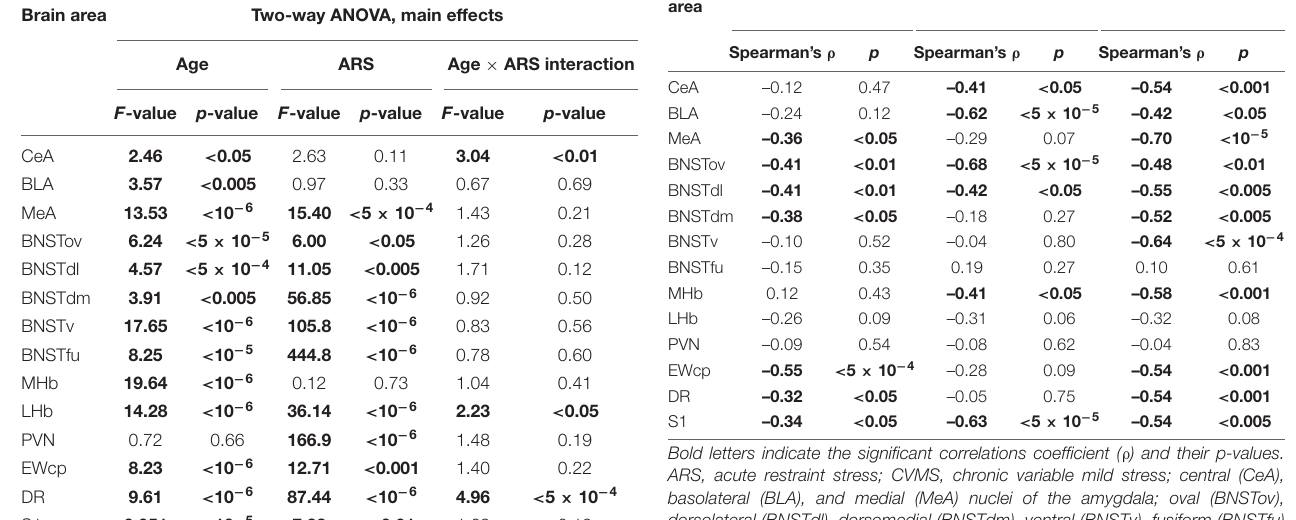
TABLE 2 | Summary of the statistical results of the two-way ANOVAs in the acute restrain stress (ARS) model. Brain area